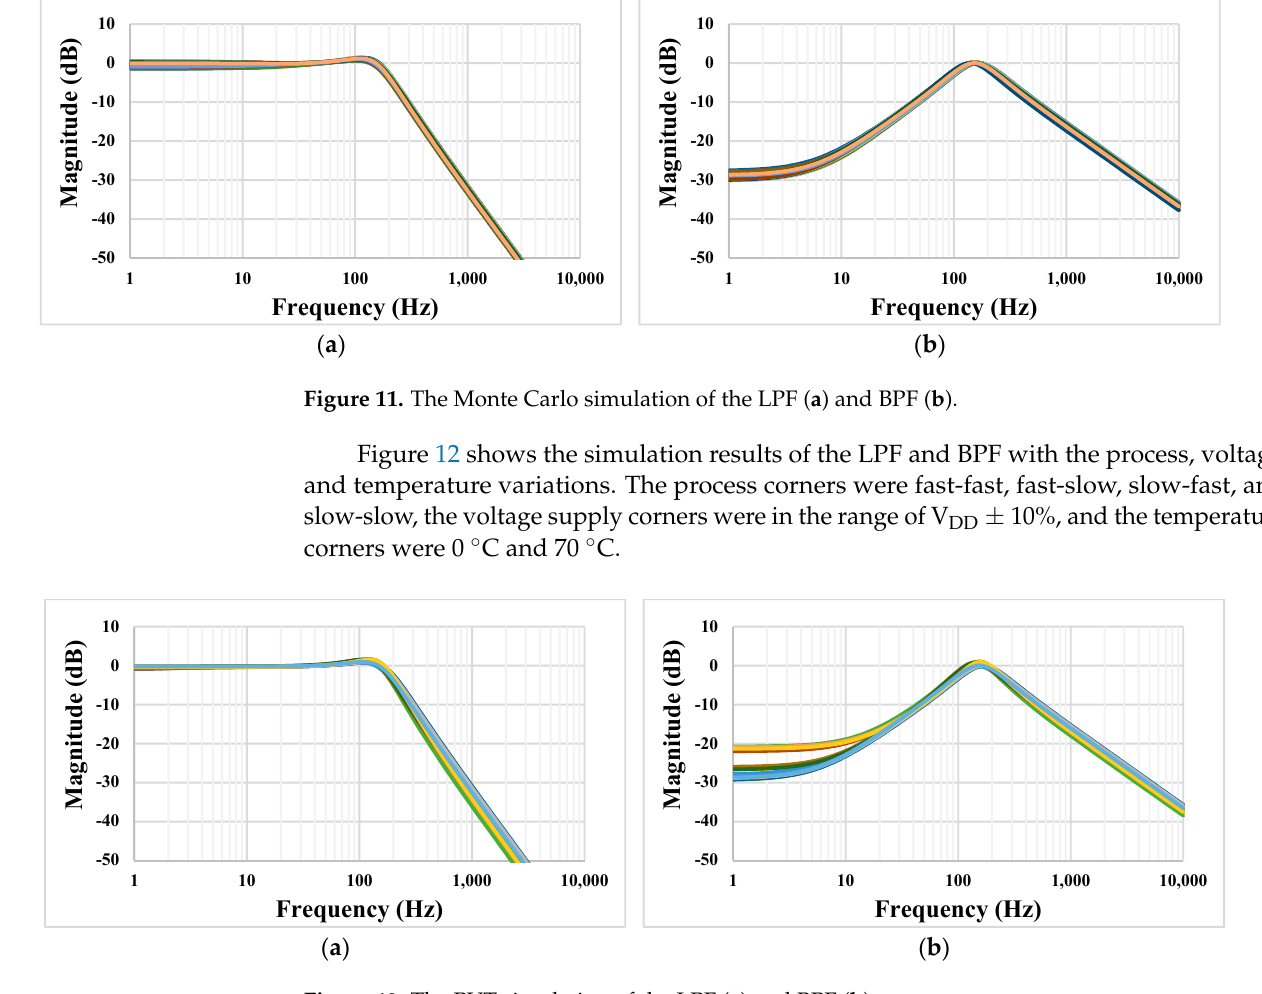
Figure 10. The simulated tuning capability of the proposed LPF ( a ), HPF ( b ), BPF ( c ) and BSF ( d ). The Monte Carlo process and mismatch analysis was performed with 200 runs. Fig- ure 11 shows the simulated results for the LPF and BPF. The low-frequency gain at 1 Hz of the LPF was in the range from − 1.39 dB to 0.47 dB, and the gain of the BPF at a frequency of 153 Hz was in the range from − 0.438 dB to 0.168 dB.